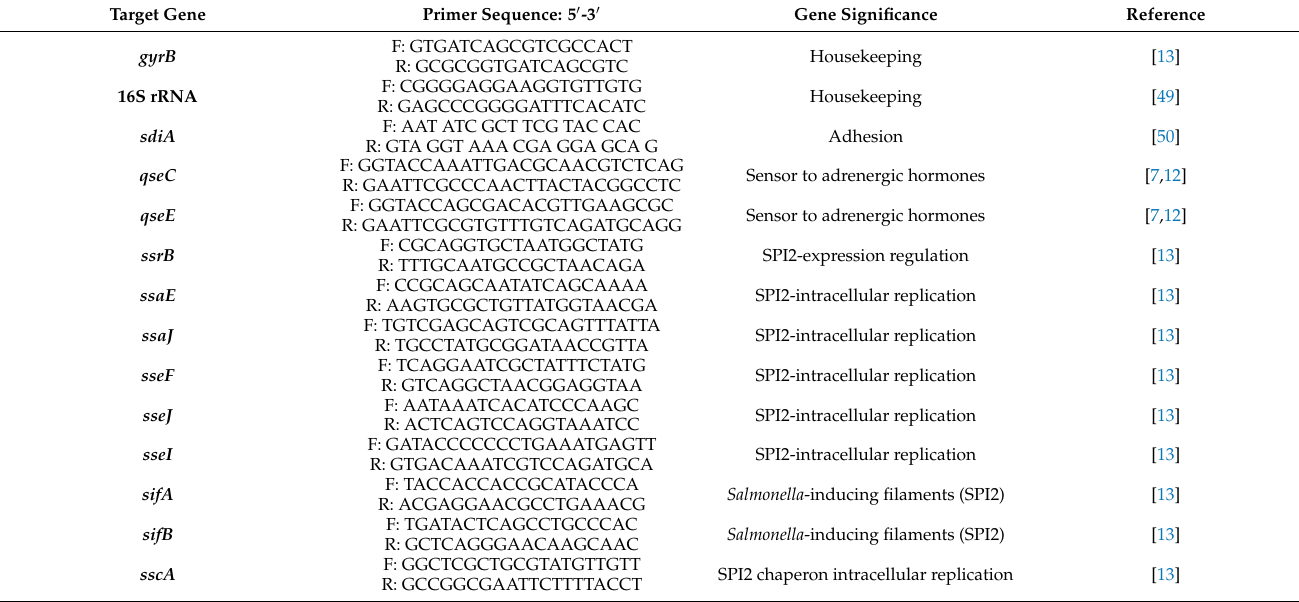
Table 1. The primers used in this